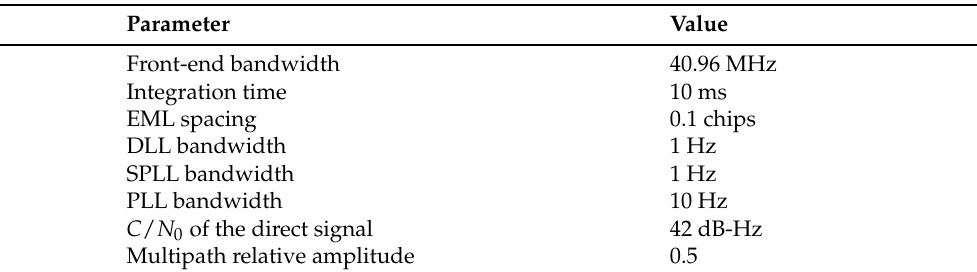
Narrow correlation